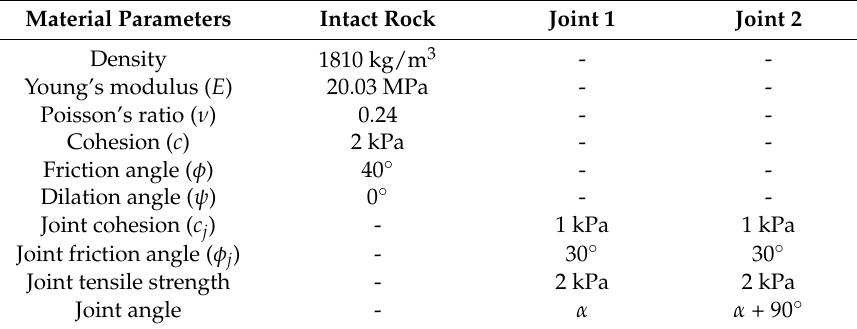
Table 2. Mechanical properties of the jointed rock mass.